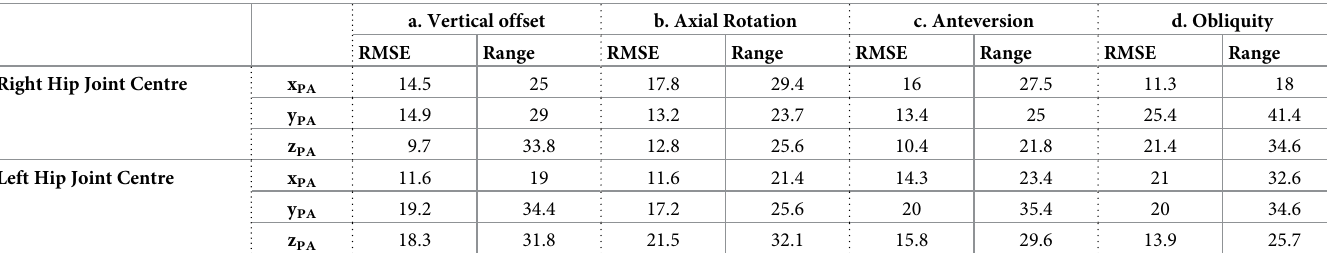
Table 1. Hip joint centre error: Regression compared to the hip joint centre identified with bi-plane X-rays. RMSE and range are in mm. a. Vertical